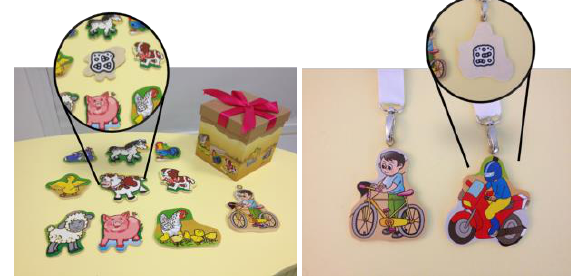
Figure 4. Physical items and attached visual markers (Left) / Tagged “identity cards” with lanyards